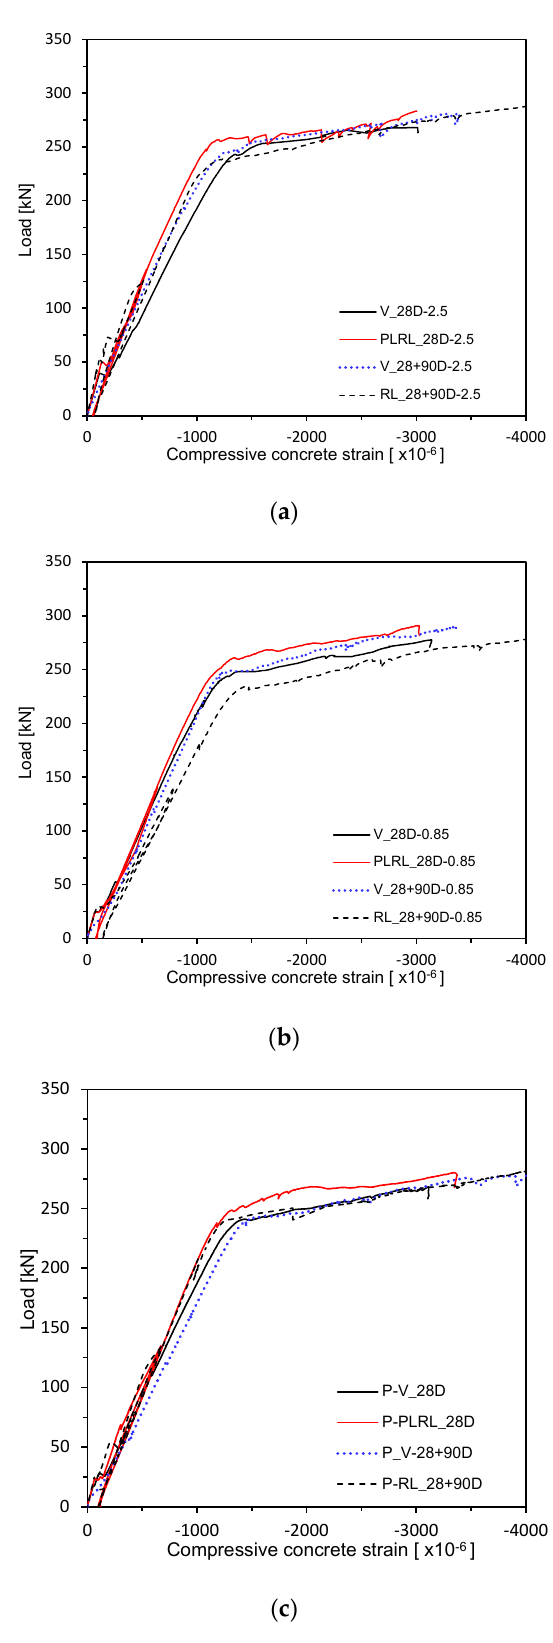
Figure 17. Load–concrete strain measurement by mixes: ( a ) 2.5 series; ( b ) 0.85 series; ( c ) Plain series.